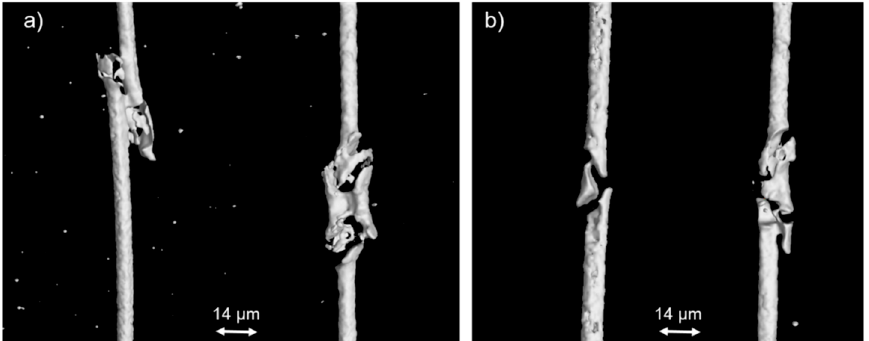
Figure 8. Example of one 3D image in high-resolution of a representative fiber fracture of each tested specimen, ( a ) with toughened matrix and ( b ) with non-toughened matrix, taken by XRM, allowing the measurement of the inclination angle of the fracture plane and the size of the small fracture pieces between single fragments.